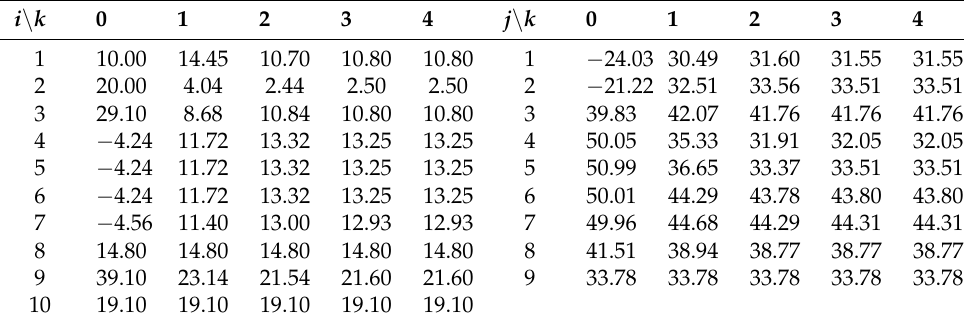
Table 2. Flow rates and pressures for iterations.